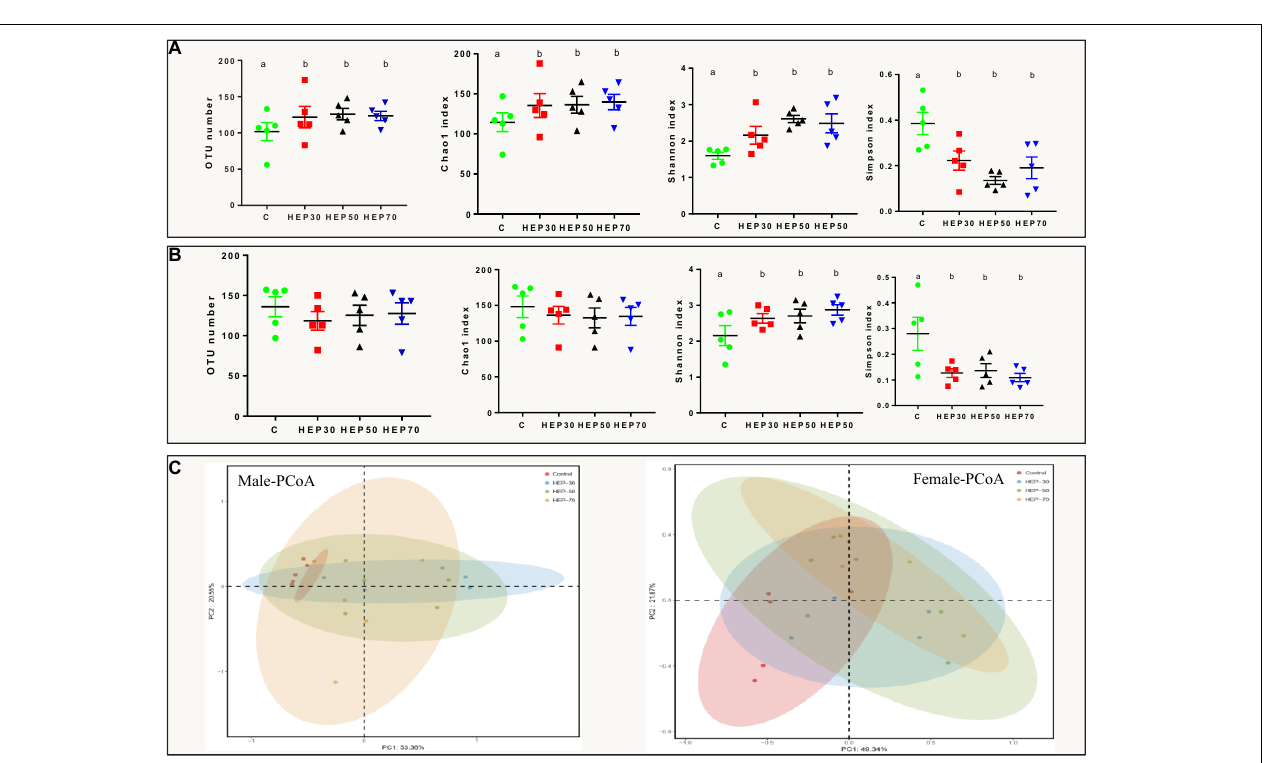
FIGURE 6 | Effects of HEPs on α and β diversity of the fecal microbiota in vitro fermentation. α diversity of fecal fermentation broth of male (A) and female (B) volunteers; (C) Principal coordinates analysis (PCoA) of microbiota of fecal fermentation broth in vitro . Data are means ± SD (5 independent experiments). a , b Different letters indicated a significant difference between the two groups ( p <